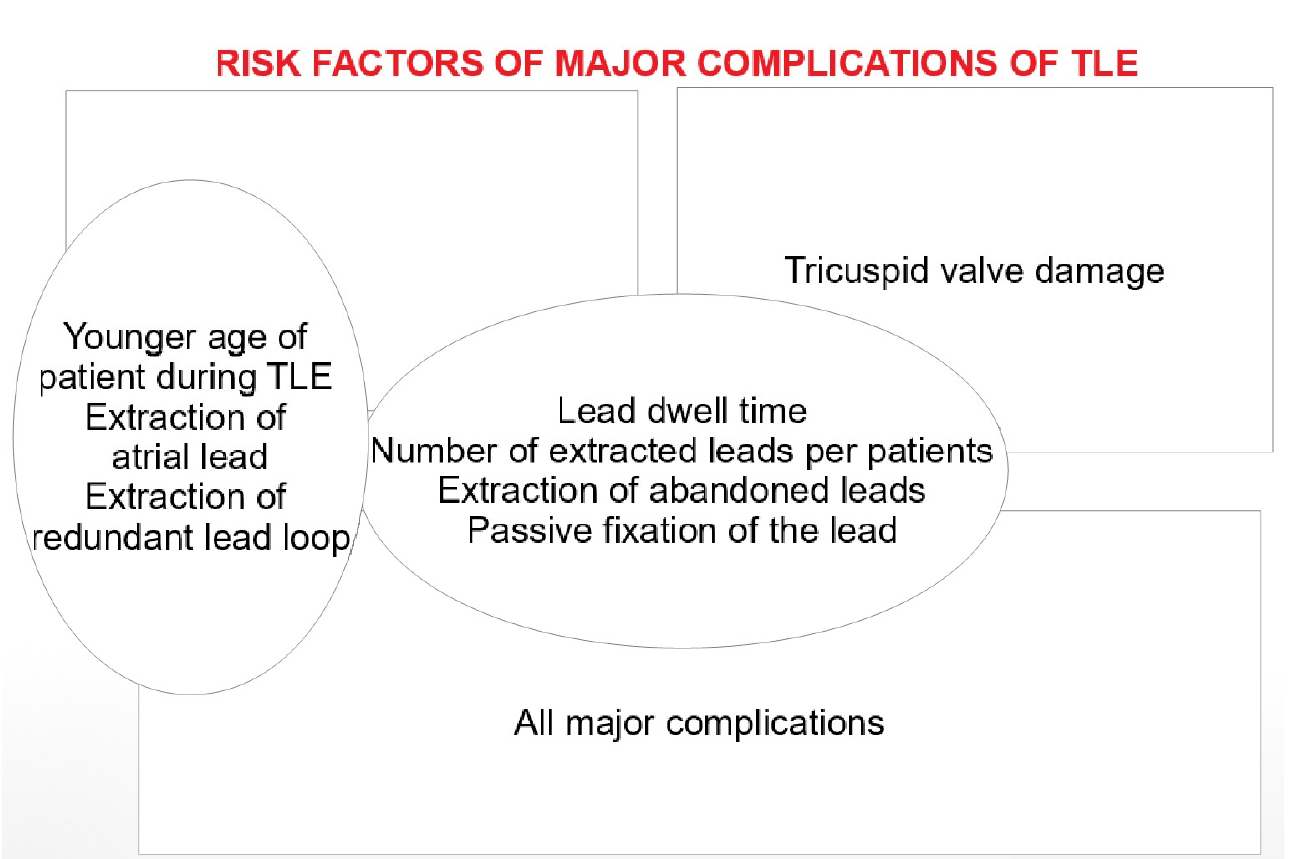
Figure 1. Graphical presentation of the main results